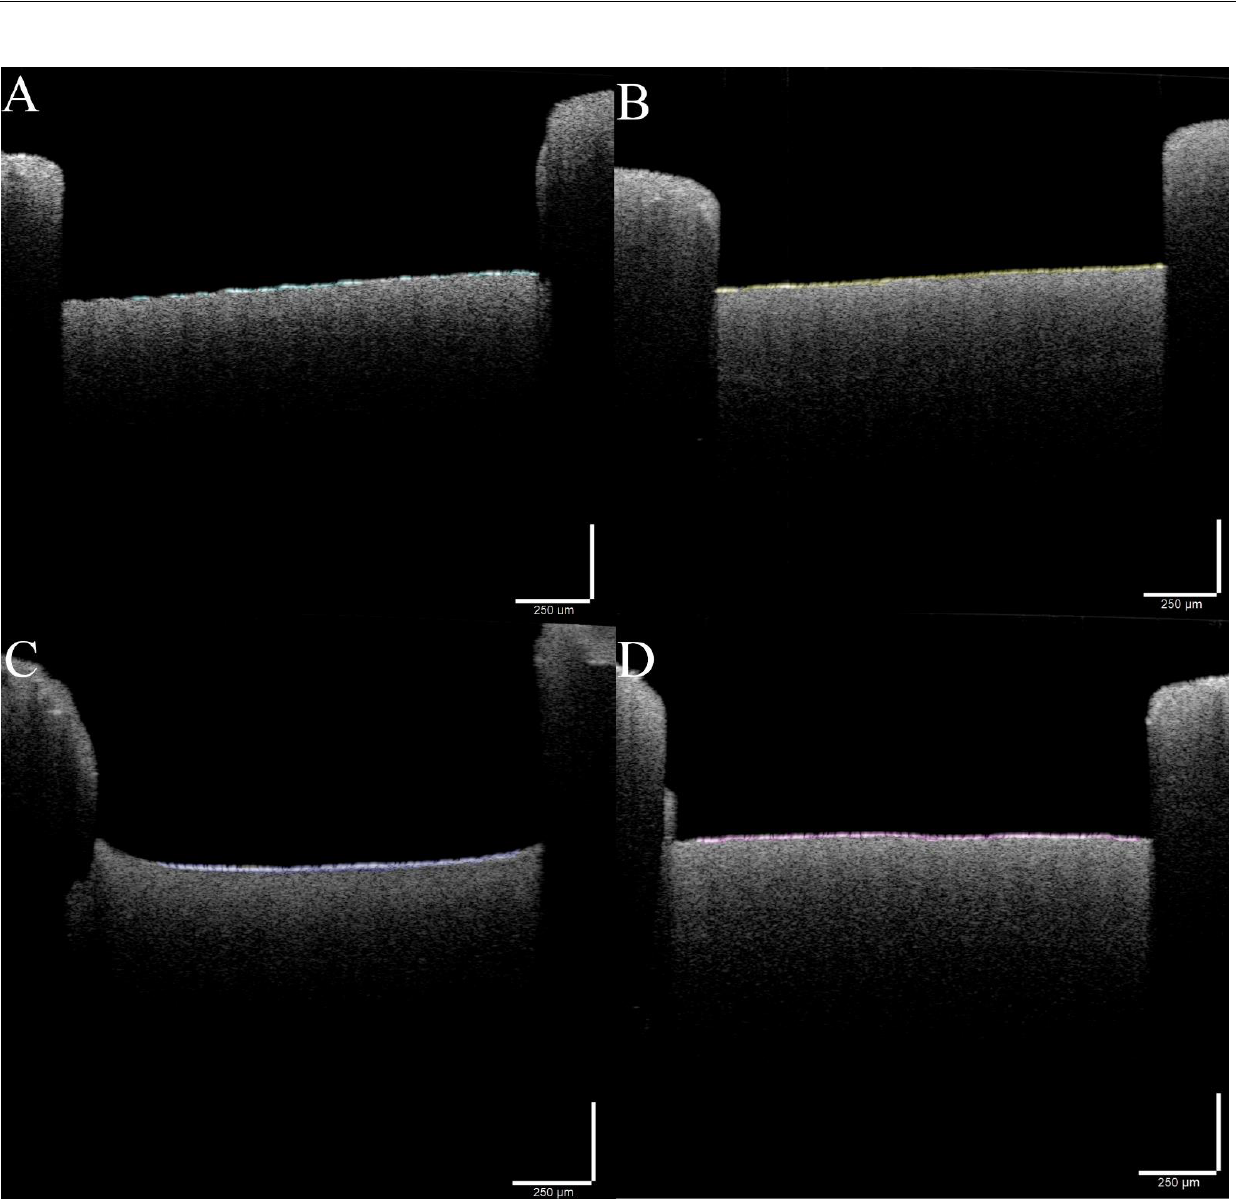
Figure 5. Optical coherence tomography (OCT) images showing the bacterial biofilm. ( A ) = Enterococcus faecalis biofilm (green), ( B ) = Staphylococcus aureus biofilm (yellow), ( C ) = Klebsiella pneumoniae biofilm (blue) and ( D ) = Pseudomonas aeruginosa (red). The strains used were Staphylococcus aureus ATCC 25923, Enterococcus faecalis ATCC 29212, Klebsiella pneumoniae ATCC 13883 and Pseudomonas aeruginosa ATCC 27853.